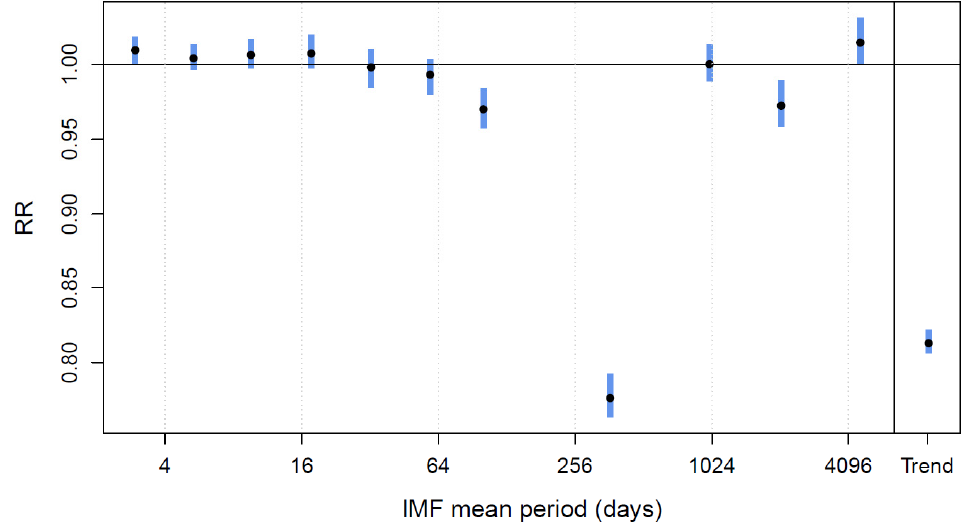
Figure 2. Relative risks (RR) of cardiovascular mortality associated to the temperature intrinsic mode functions (IMF) kept by the Lasso versus to the mean period of the IMF. Blue bars indicate 95% confidence intervals.